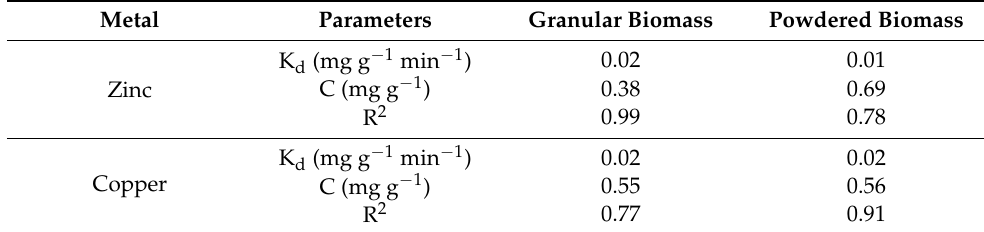
Table 4. Parameters of the Weber and Morris kinetic model.